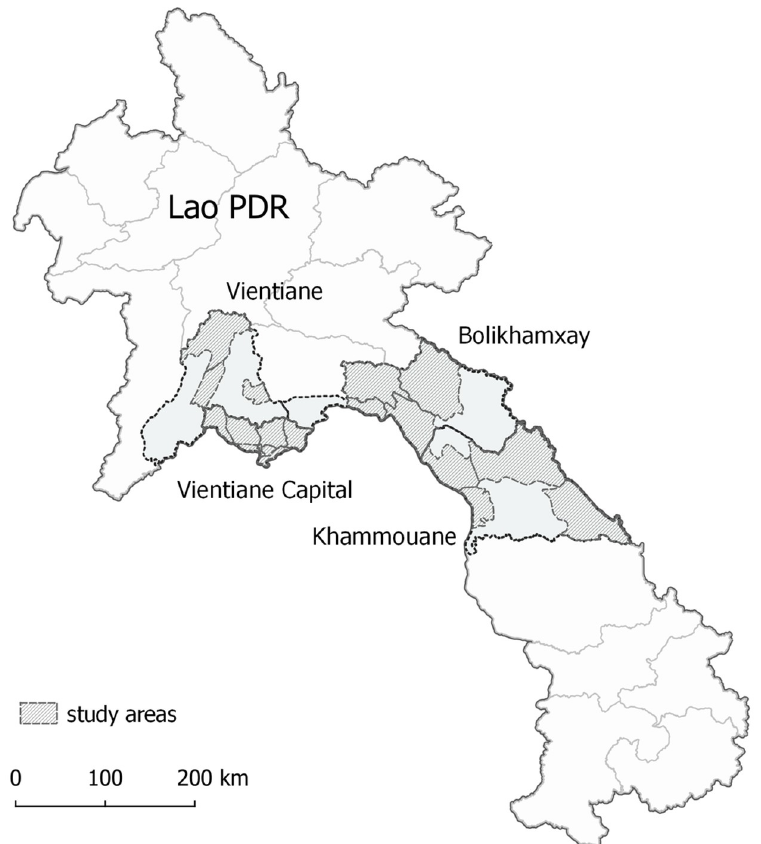
Fig 1. Map of study sites in Lao PDR. Districts in which samples were collected are highlighted. The map was created with QGIS (QGIS Development Team, 2018). The data regarding the administrative boundaries of Lao PDR was obtained from the Humanitarian Data Exchange website (https://data.humdata.org/dataset/lao-admin-boundaries, dataset provided by the National Geographic Department of Lao PDR, 2019). Projection used: EPSG 4326 –WGS